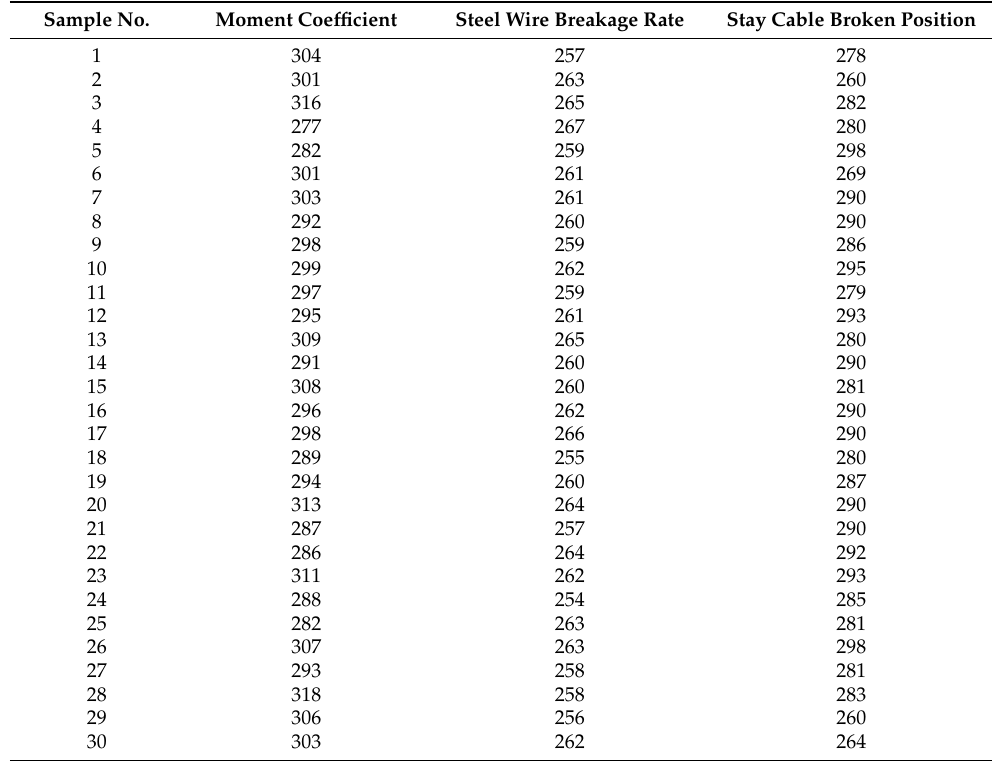
Table 6. Aerostatic instability wind speeds corresponding to 30 samples for different parame- ters (m/s).